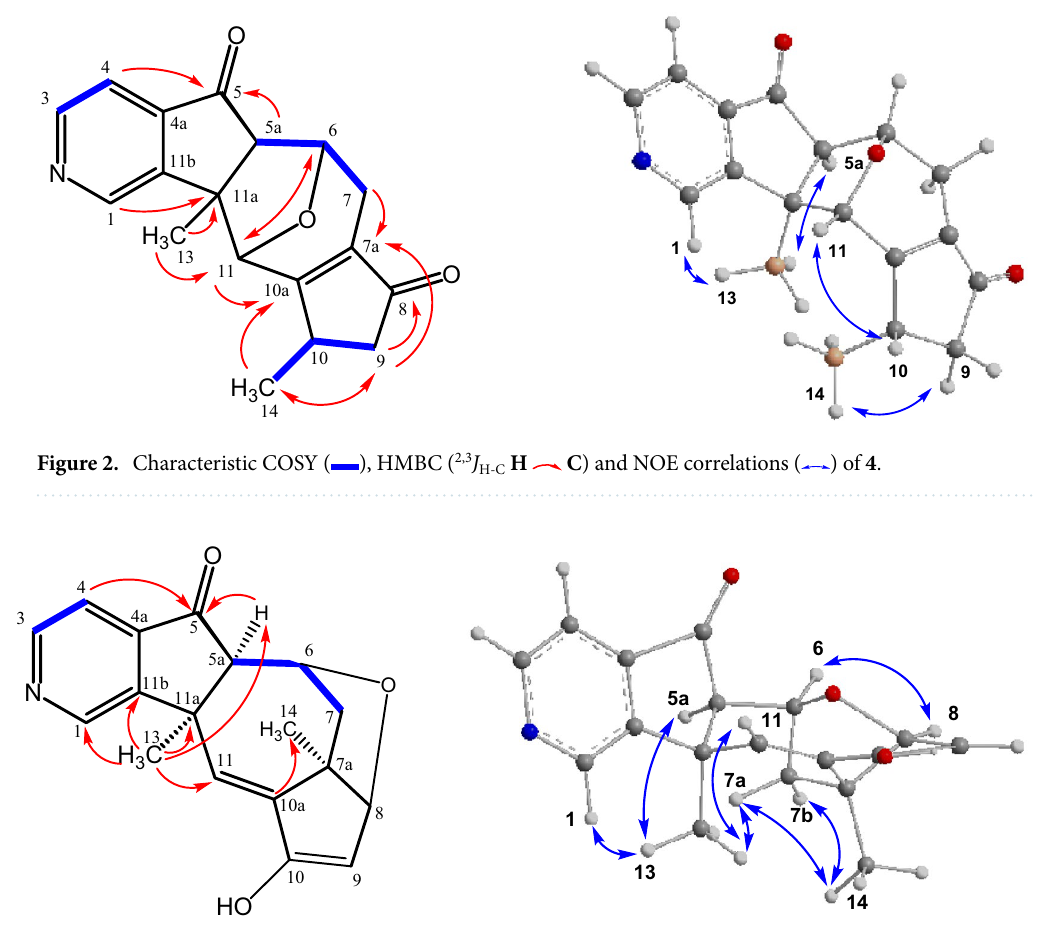
Figure 3. Characteristic COSY ( ), HMBC ( 2,3 J H-C H C ) and NOE correlations ( ) of 5